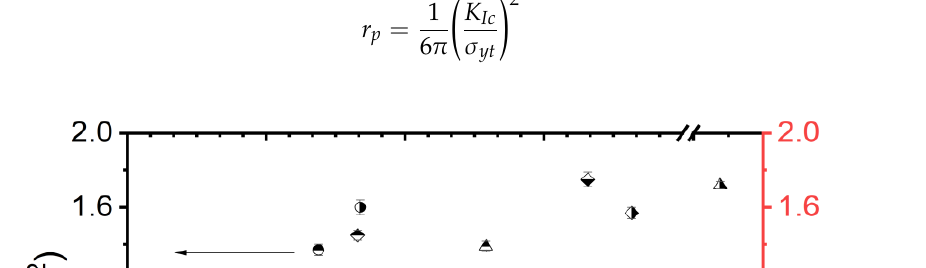
Figure 4. SEM micrographs of the fracture surface of the different hybrid systems. Black arrow indicating the direction of crack propagation. ( a )EP_5CSR_10SiO 2 ; ( b ) EP_5CSR_0.1CNT.